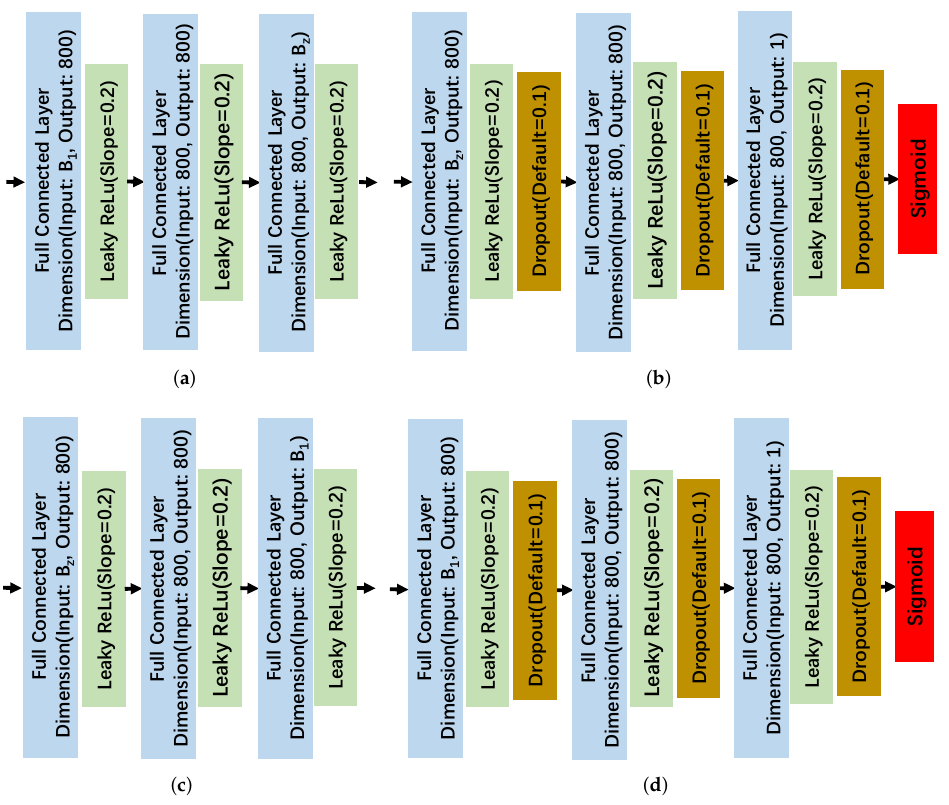
Figure 2. The more specific details of constrained two GANs components. ( a ) Generator (En). ( b ) Discriminator (Dz). ( c ) Generator (De). ( d ) Discriminator (Do).